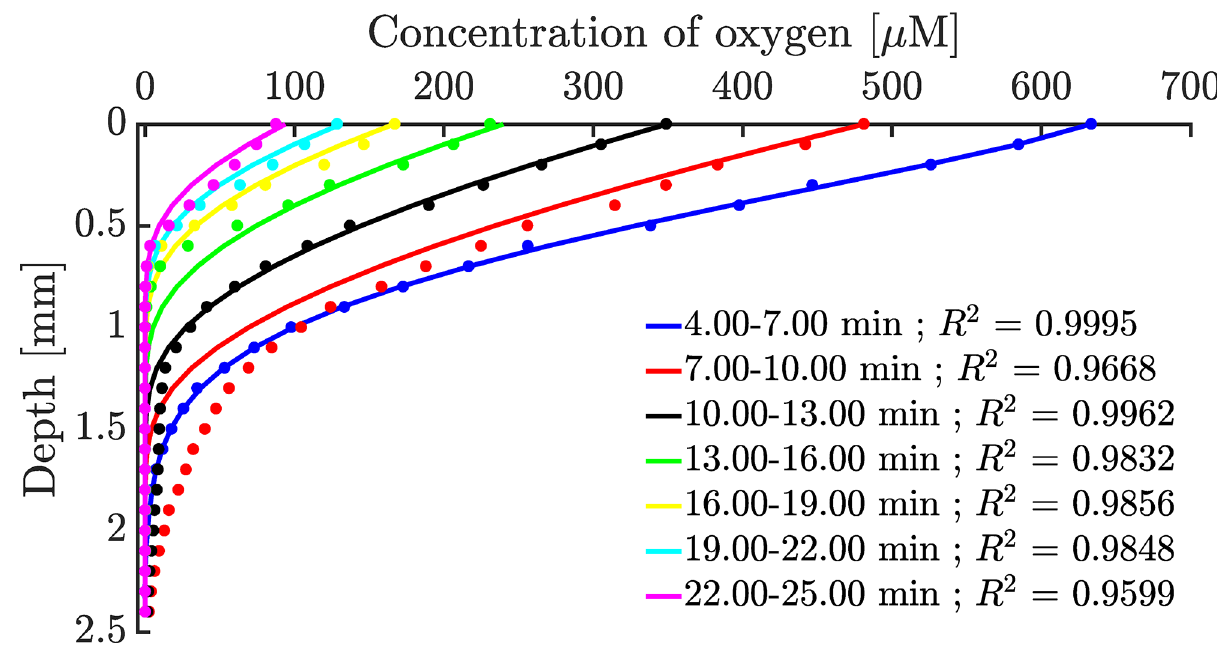
Fig 4. Numerical solutions of the reaction-diffusion equation with a michaelis-menten reaction term. Dots are experimental data from Fig 1 and the coloured lines are matching numerical solutions to Eq (4). The biofilm extends from depth 0 mm to 5 mm, but only the part with measurable oxygen concentration is shown in the